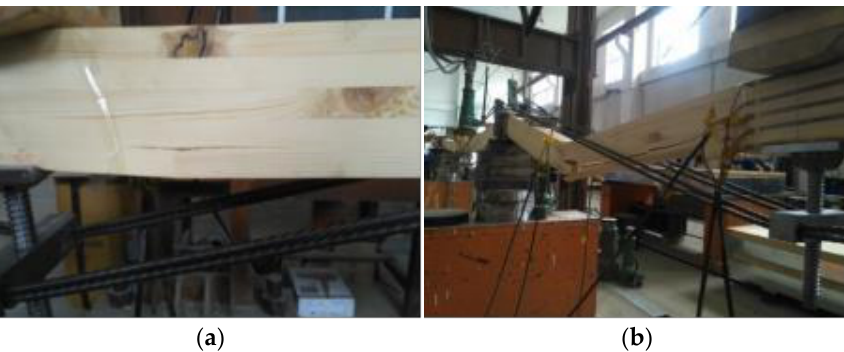
Figure 17. Failure mode of L B3 . ( a ) Initial fracture of right span; ( b ) Tensile failure of right span.